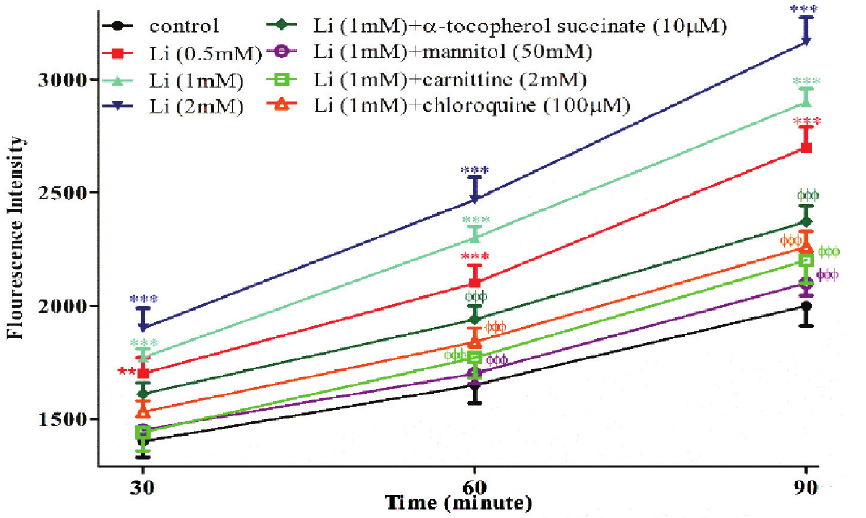
Figure 2: Effect of different concentrations of Li on ROS formation using primary neuronal cortical culture. Reactive oxygen specious were determined spectrofluorometrically by the measurement of highly florescent DCF. Values are shown as mean ± SD of three separate experiments (n = 3). ** p < 0.01, *** p < 0.001, significant difference in comparison with non-treated neurons (control). ɸɸɸ p < 0.001, significant difference in comparison with Li (1 mM)-treated